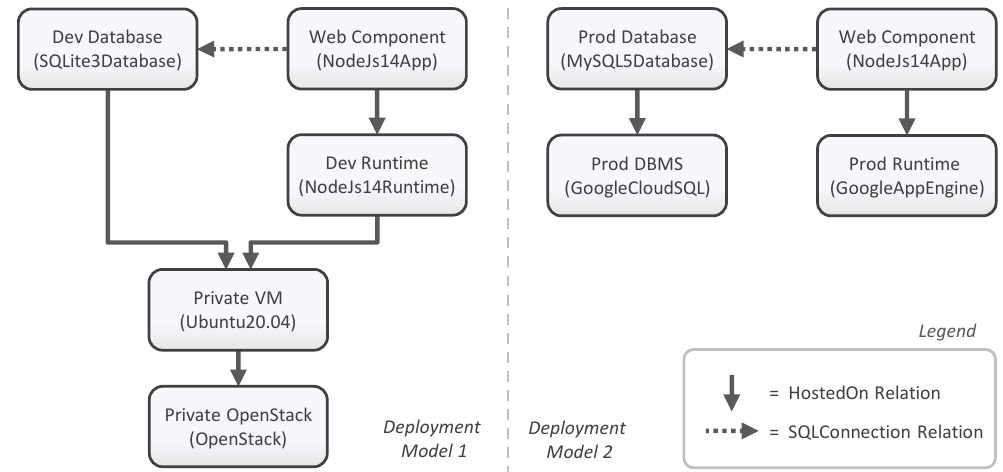
Figure 1. Two different deployment variants for the motivating scenario: deployment model 1 for development ( left ) and deployment model 2 for production ( right